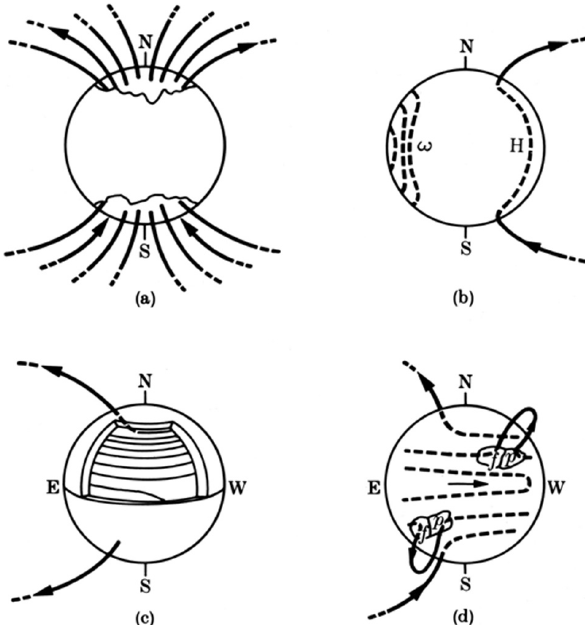
Fig. 1a. Schematic illustration of how sunspot pairs are formed by the non-uniform rotation of the Sun (Babcock, 1961).